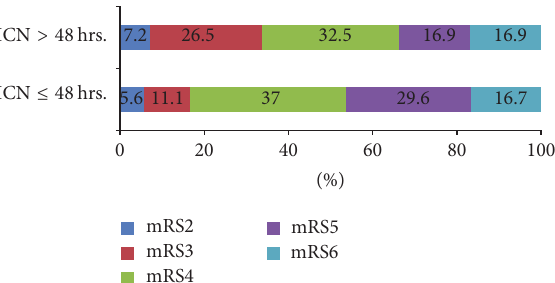
Figure 1: Outcome at three months with DHC more than 48 hours versus at or less than 48 hours [ 𝑃 = 0.140 ].